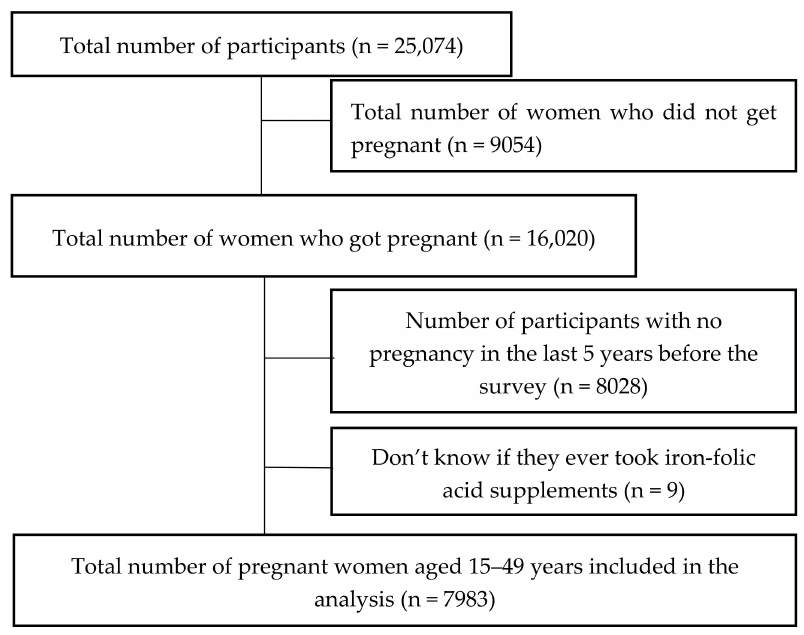
Figure 1. Flowchart for participant